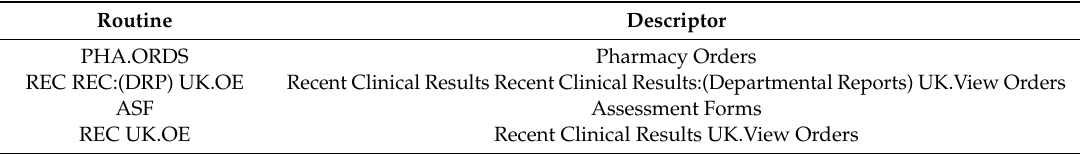
Table 2. EPR audit sample data.